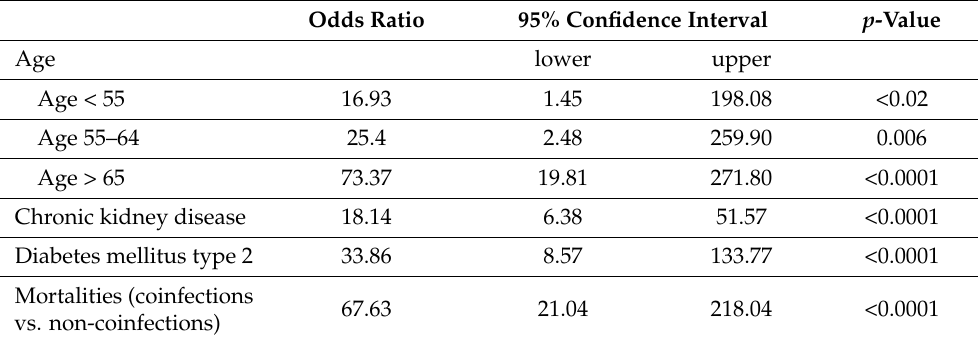
Table 4. Multivariate logistic regression analysis among hospitalized COVID-19 patients and mortal- ity cases (142 survived vs. 36